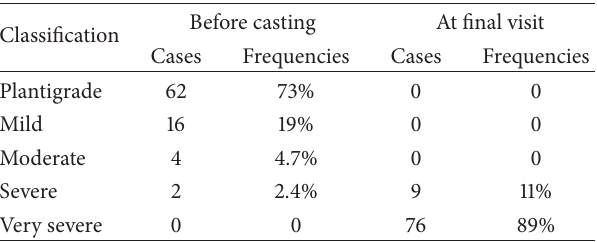
Table 2: Dim´eglio score, before serial casting and at final follow-up